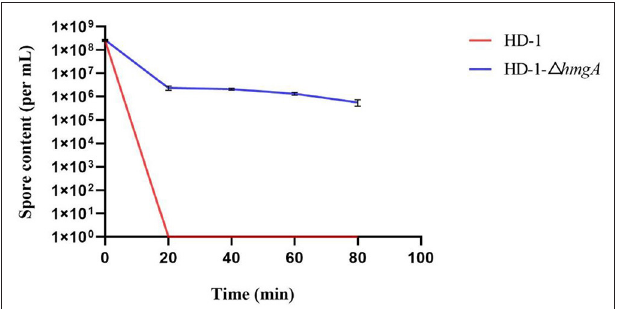
FIGURE 5 | Total spore content after UV irradiation.